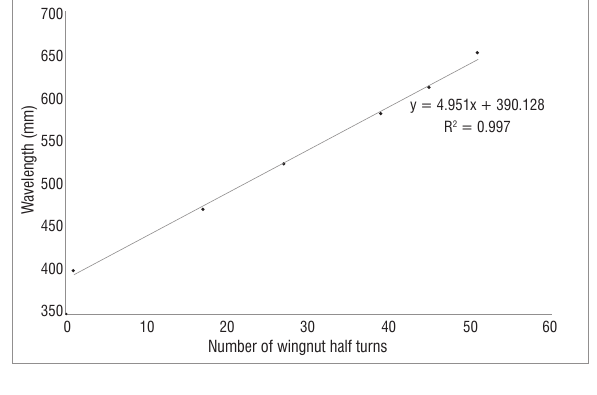
Figure 7: Calibration curve for wavelength as a function of the number of half turns of the cuvette sample holder wingnut obtained by using the SpecUP in Mode 2.